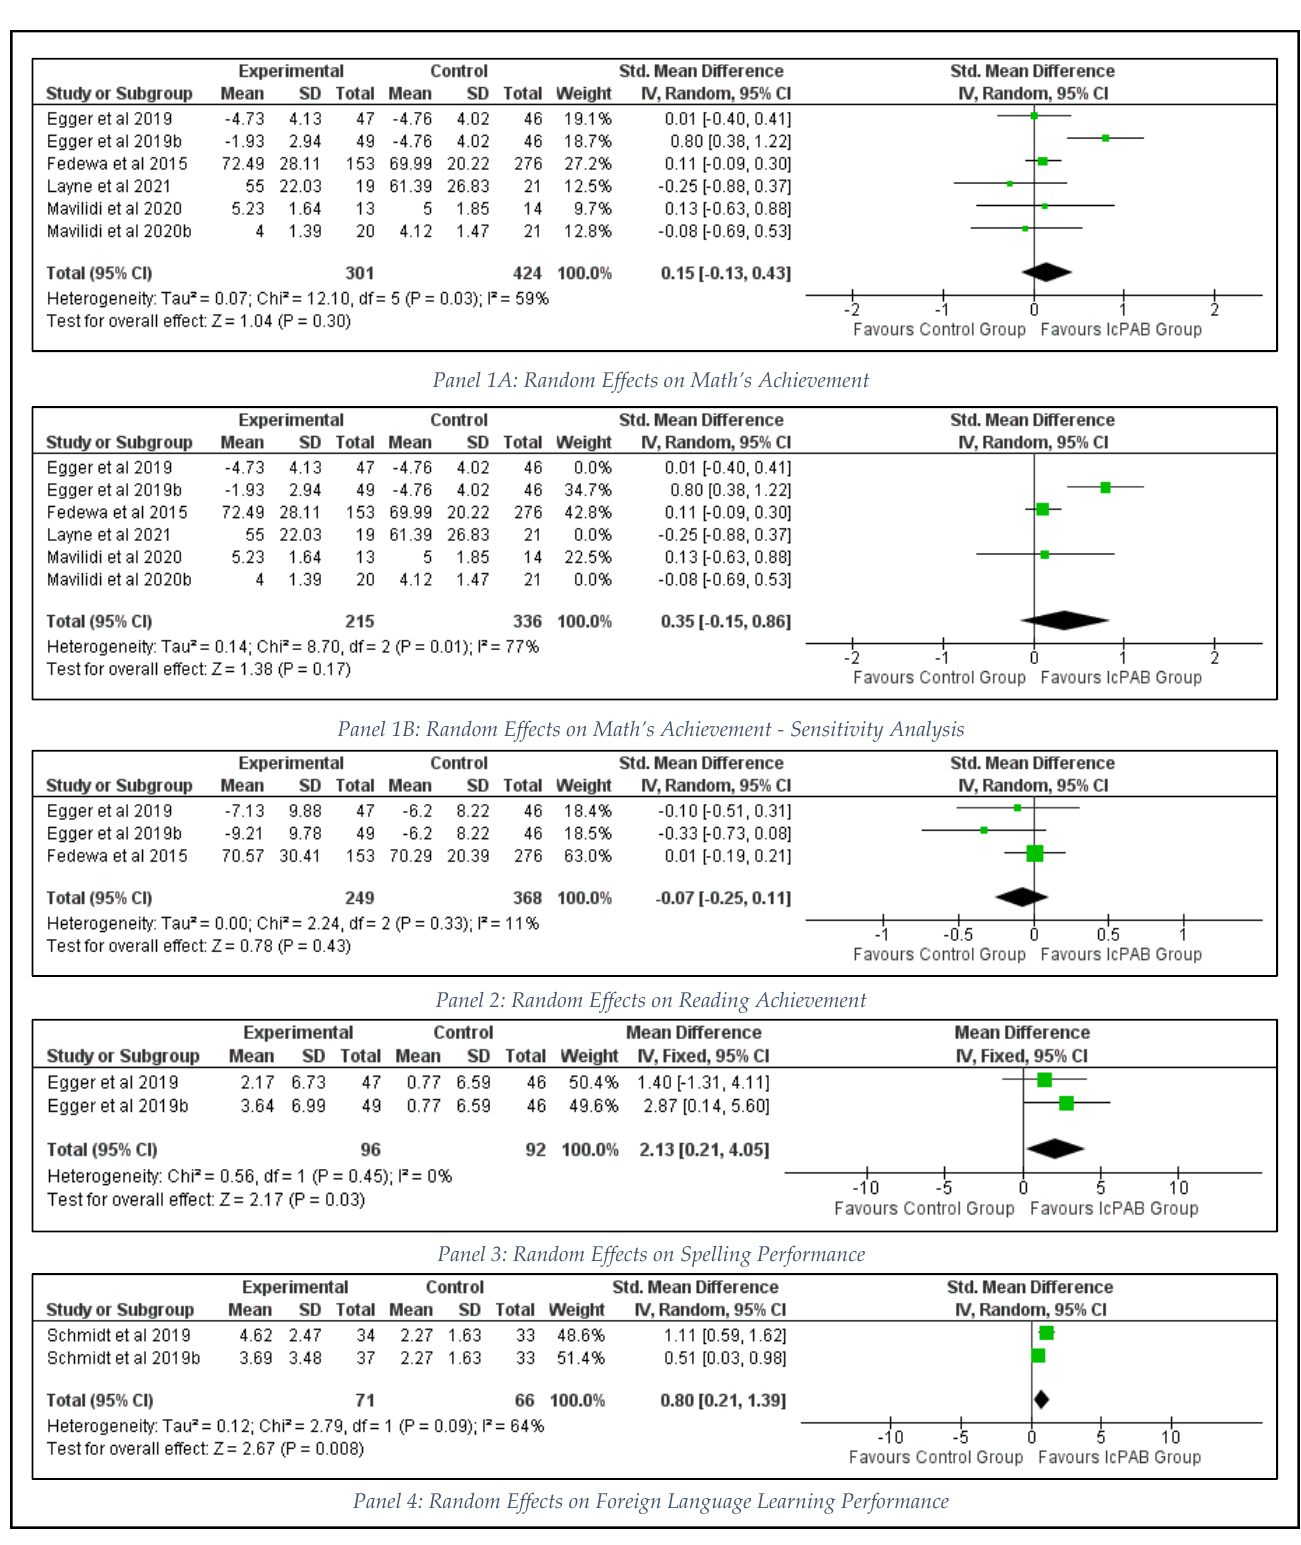
Figure 2. Effects of IcPAB on Academic Achievement Outcomes.